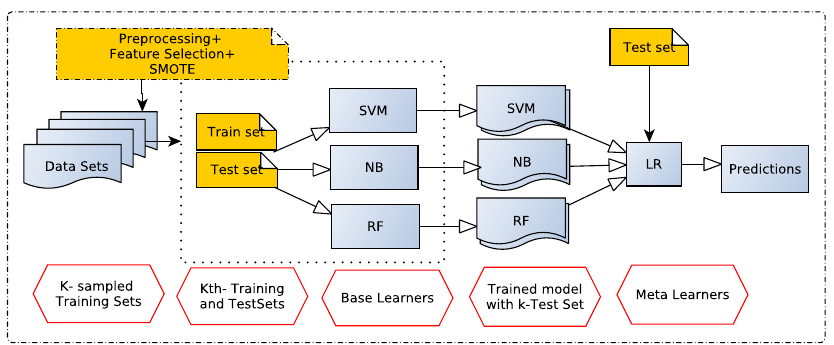
Figure 2. Proposed stacking sentiment